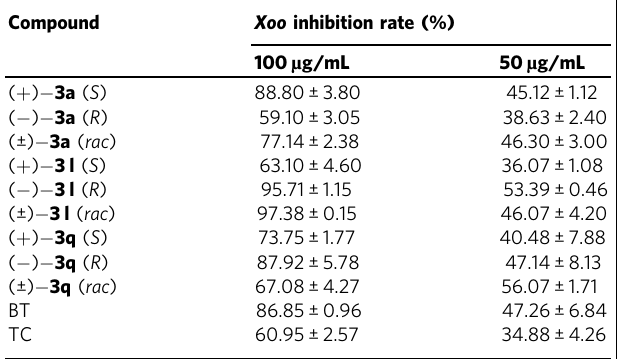
Table 3 Inhibitive activities of the axial chiral compounds against Xoo a .